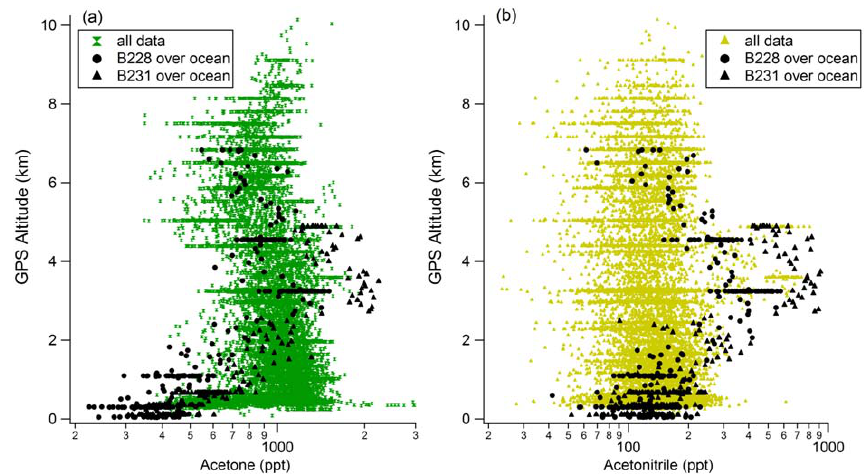
Fig. 8. Vertical profiles of (a) acetone and (b) acetonitrile for all campaign data in coloured symbols and specifically for the data over the Gulf of Guinea, south of 6.3 ◦ N on Flight B228 ( • ) and Flight B231 ( N